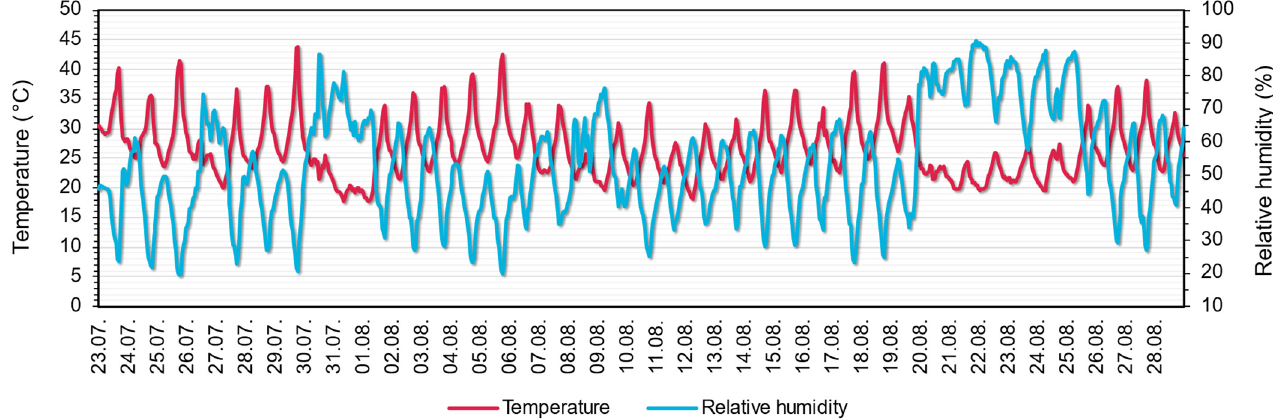
Figure 9. Measured external temperature and relative humidity.